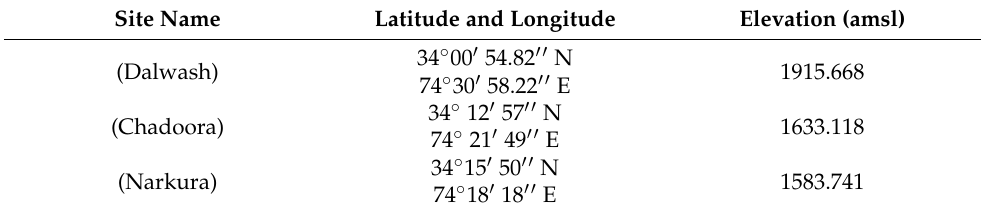
Table 1. Site characterization of the study